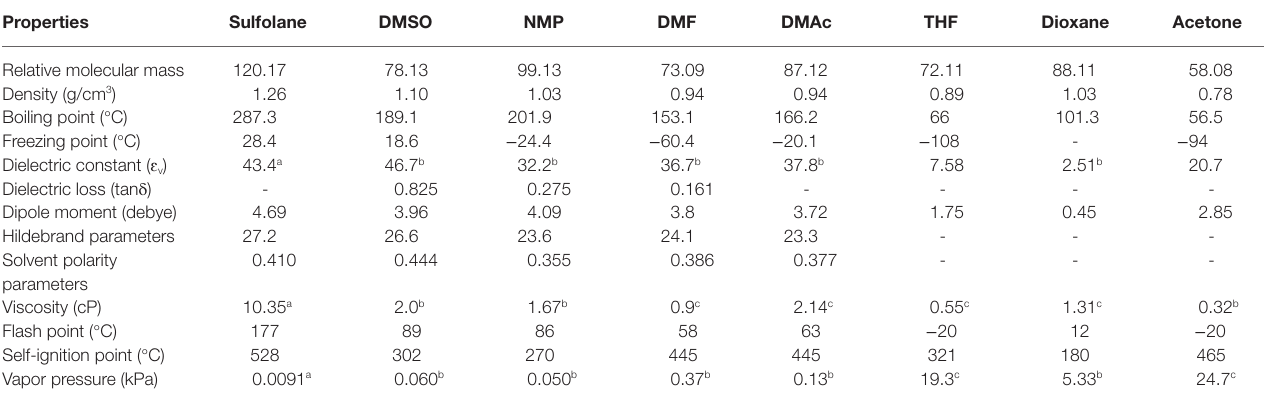
TABLE 2 | Properties of usual polar aprotic